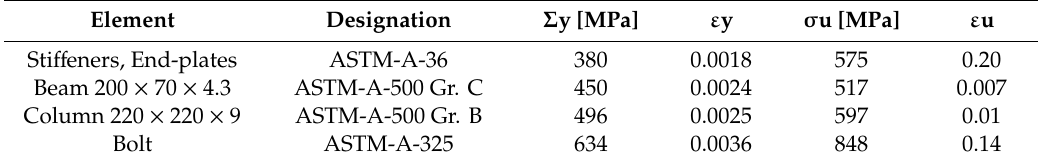
Table 2. The instrumentation consisted of 3 LVDTs (linear variable di ff erential transformers) to obtain the displacements of interest and load cell to record the applied load. Table 2. Tensile coupon specimen properties.